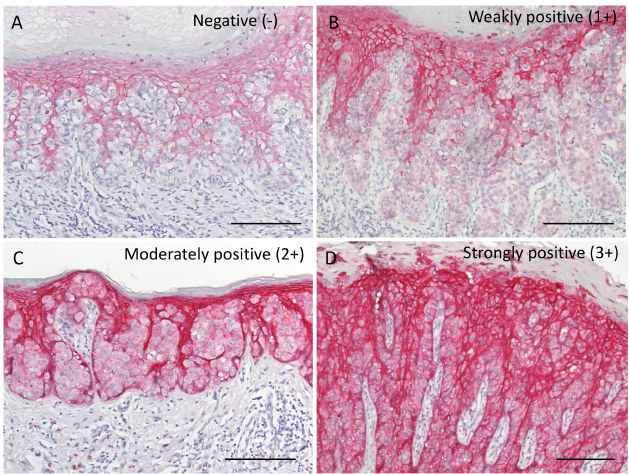
Figure 2. ( A – D ) Representative histopathological images of ( A ) negative ( − ), ( B ) weakly positive (1+), ( C ) moderately positive (2+), and ( D ) strongly positive (3+) staining for Trop2. Positive Trop2 signals were mainly found in the cytoplasm and on the membranes of tumor cells. Bars indicate 100 µ m. Trop2, trophoblast cell surface antigen 2.